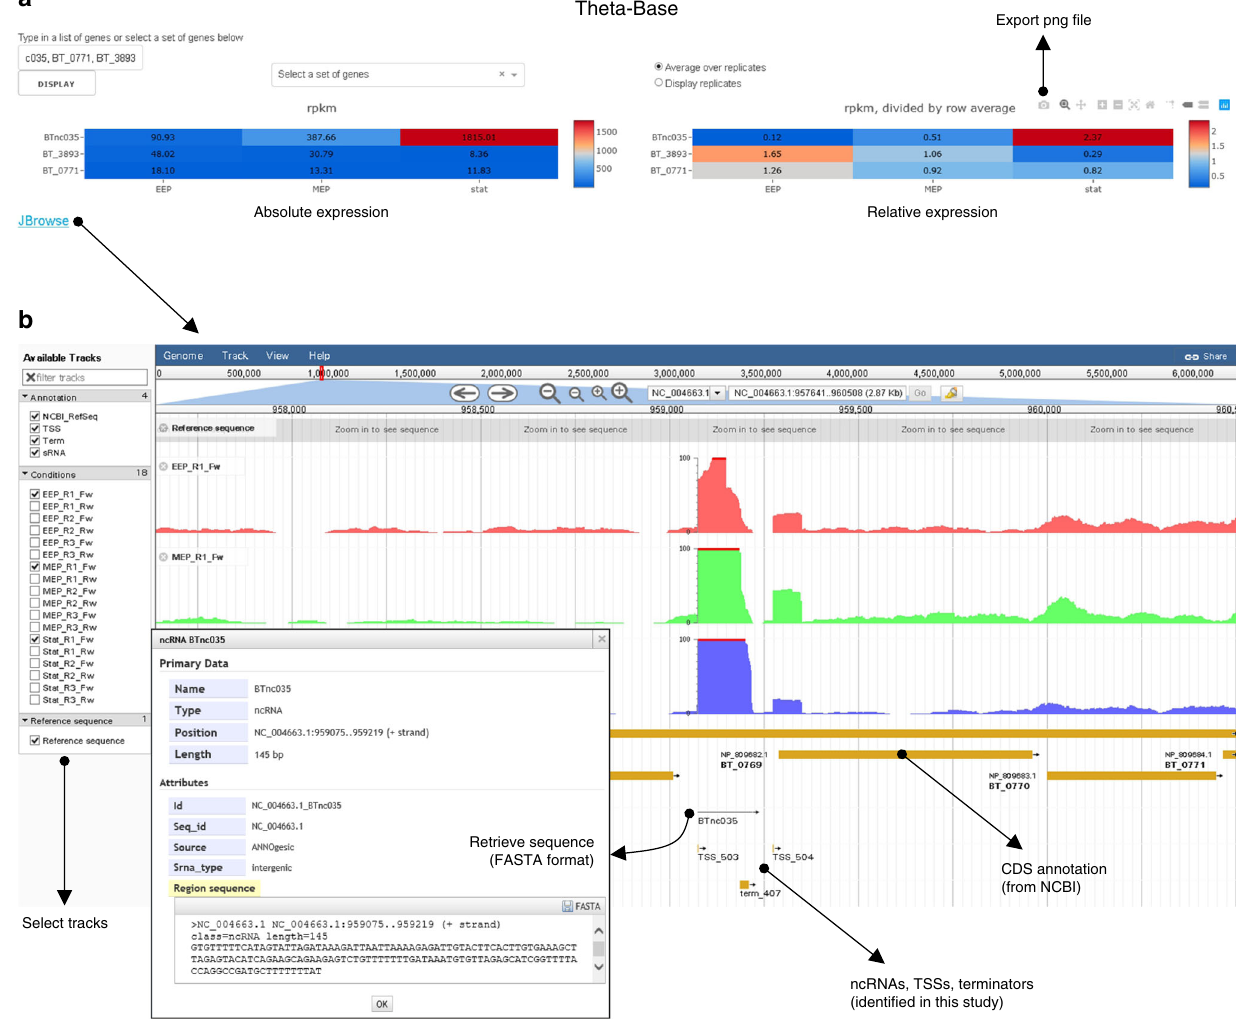
Fig. 2 Theta-Base allows easy access to B . thetaiotaomicron transcriptomic features. a Heatmap representation of absolute (reads per kilobase of transcript per million mapped reads [rpkm]; left) or relative (rpkm divided by row average; right) transcript levels illustrates the anti-correlation in expression of GibS (a.k.a. BTnc035) and its repressed targets ( BT_0771 , BT_3893 ; as identi fi ed in Fig. 5) over growth in TYG. For visualization, query genes (coding and noncoding) may either be entered individually in the upper left box or selected from pre-de fi ned gene sets. Biological replicates can be displayed individually or (as in the given example) the average expression over each three replicates may be shown. ‘ EEP ’ refers to early, ‘ MEP ’ to mid- exponential, and ‘ stat ’ to stationary phase. The heatmap can be exported as a graphic fi le in the upper right corner. At the lower left corner is a link to the genome browser ( b ). b JBrowse view on the read coverages over the GibS-encoding locus within the B . thetaiotaomicron genome. Tracks for display can be selected on the left (i.e., annotated coding and noncoding genes and transcript features [transcription start sites, terminators] as well as different experimental conditions and replicates). At the top, gene names or genome coordinates may be entered; zoom-in and -out functions exist. Inset: By clicking on any of the annotated features, primary sequences can be retrieved in FASTA